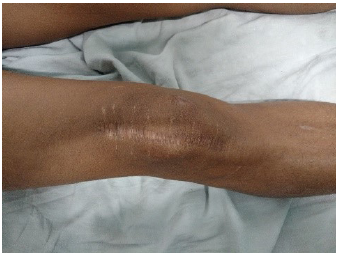
Figure 4. Surgical scar present in midline as well as wound scar present on medial aspect of patella.